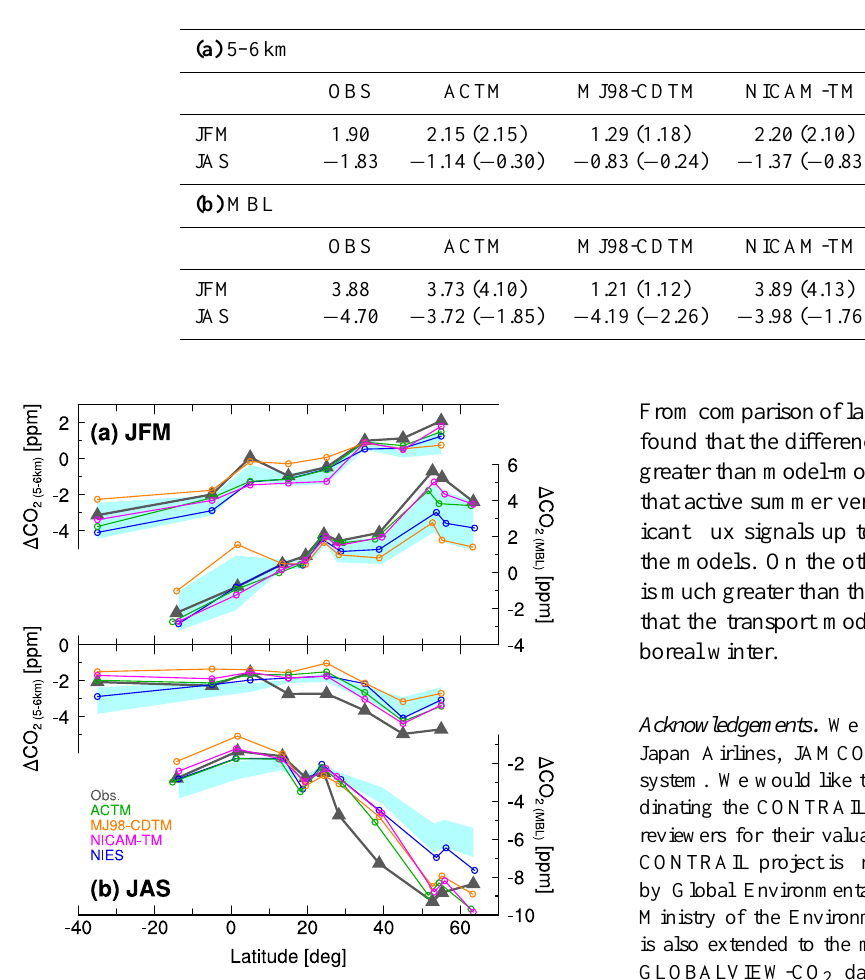
Table 7. Latitudinal difference of mean 1 CO 2 between north (20–70 ◦ N) and tropics (20 ◦ S–20 ◦ N) at 5–6km in the free-troposphere (a) and in the marine boundary layer (MBL) (b) . Simulated results are derived using Flux2 and Flux1 (parenthetical values).